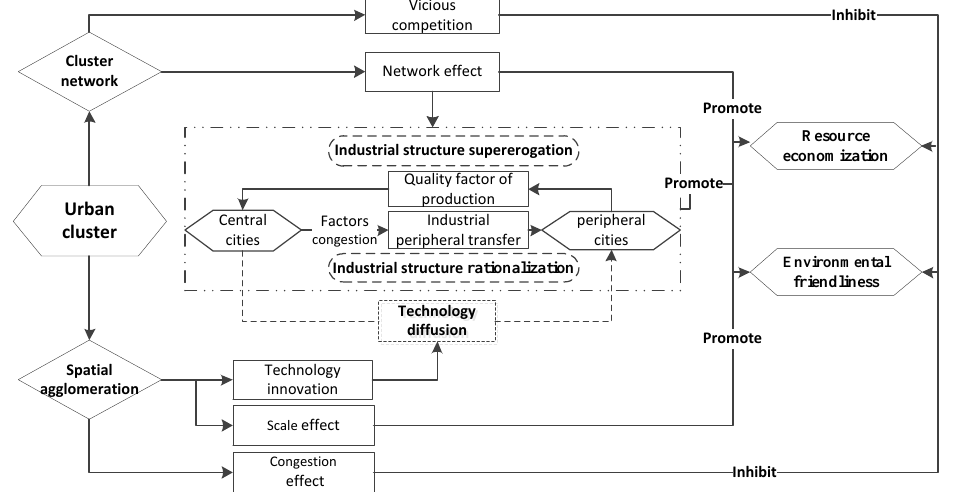
Figure 1. Diagram of analytical framework.